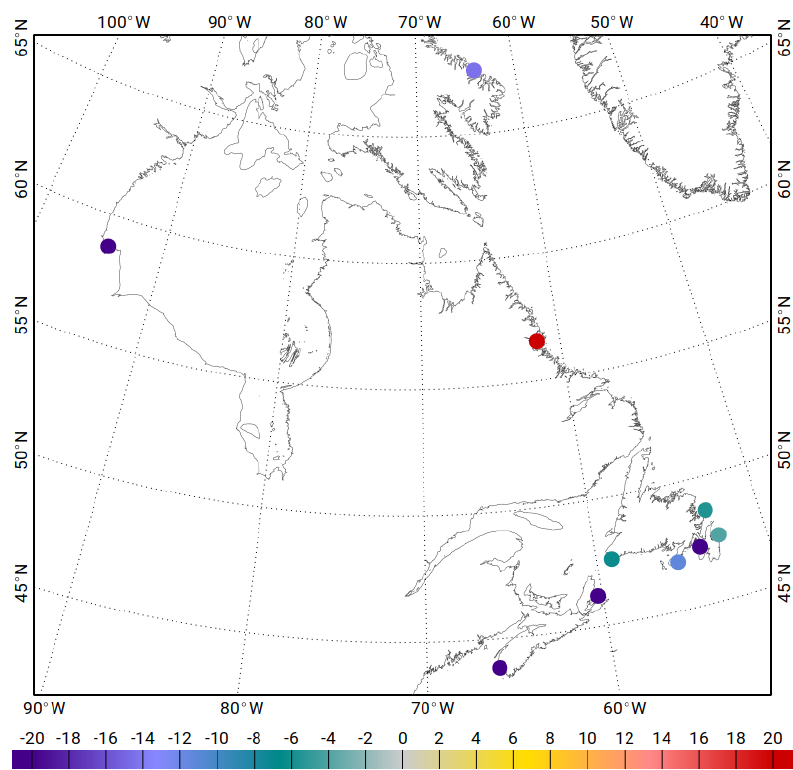
Figure 14. Variance reduction differences (cm 2 ) at Canadian tidal gauge sites, when using the FES2014b atlas versus the GOT4v10 at- las. Analysis computed over the 2007 to 2011 time period. Blue colours indicate a higher variance reduction when using FES2014b tidal correction. Tidal corrections made for both models with their native constituents’ spectrum (i.e. not restricted to their common